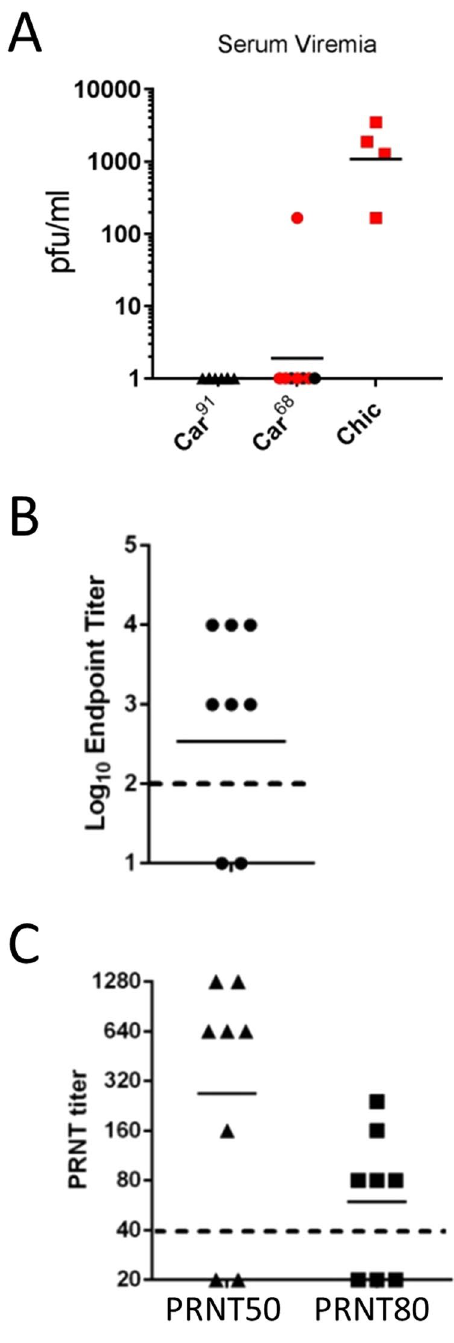
Figure 2. Evaluation of serum from MACV infected guinea pigs. ( A ) Viremia was determined on Vero cell monolayers using guinea pig serum taken from survivors on day 30 (black) or when animals were euthanized (red). The solid line represents the GMT values. ( B ) Antibody binding ELISA titers were determined by incubating sera from Car 91 -infected animals with PsVs pseudotyped with GPC from Strain Carvallo. Antiserum samples were serially diluted prior to incubation. The dashed line denotes the limit of detection. The solid line represents the GMT value. ( C ) Titer of neutralizing antibody in Car 91 -infected animals was determined and PRNT50 and PRNT80 titers were plotted. The dashed line denotes the limit of detection. The solid line represents the GMT